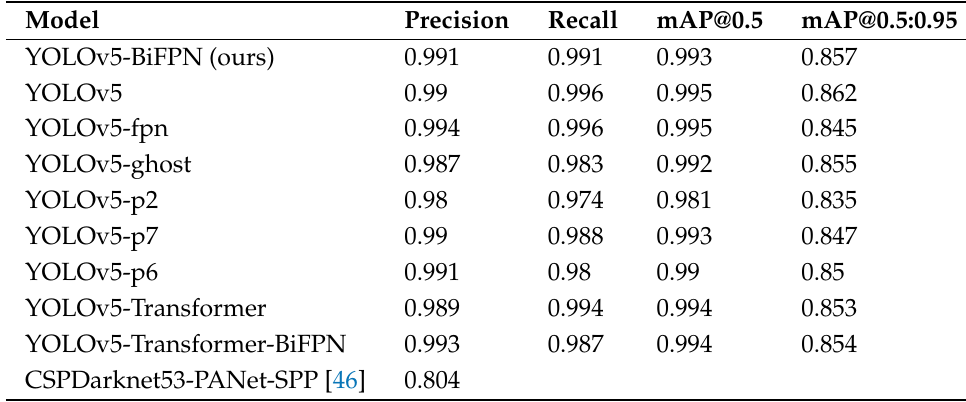
Figure 16. ( a ) Training-Loss and ( b ) Accuracy Graph. Table 2. Model evaluation results on the test